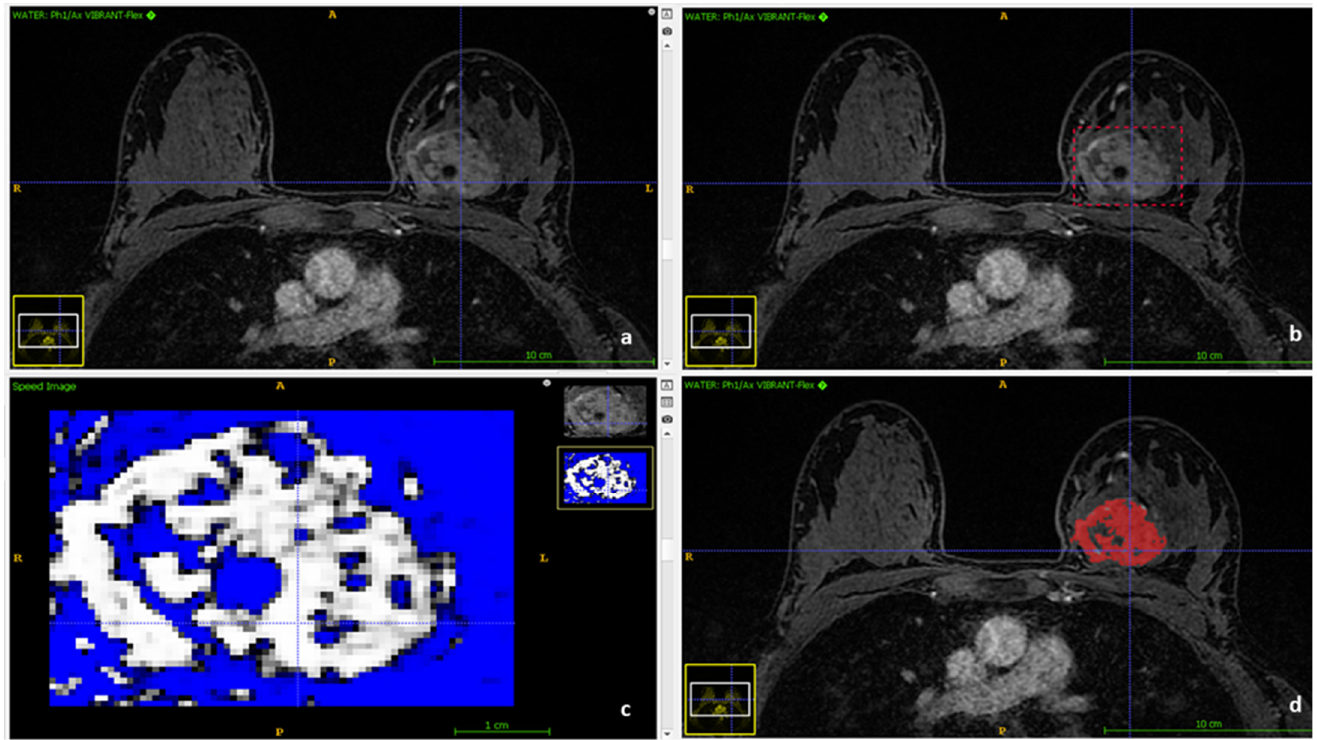
Figure 2. Segmentation process using ITK-SNAP. ( a ) Contrast-enhanced water suppressed T1-weighted series imported in ITK-SNAP. ( b ) Manual delineation of tumor ’s volume by a dedicated breast radiologist. ( c ) Semiautomatic segmentation based on iterative adaptive thresholding. ( d ) The final volume of interest (VOI).